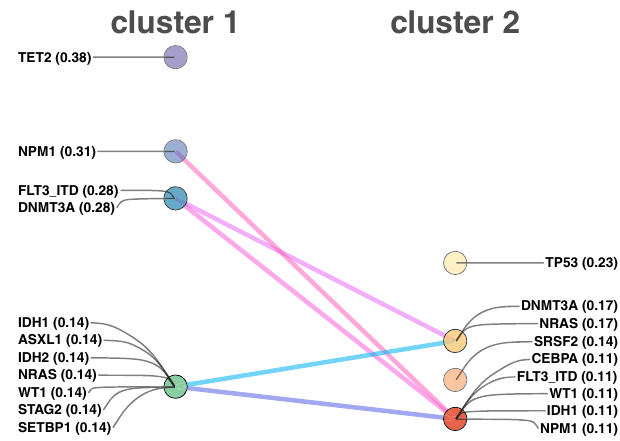
Fig. 6 The frequently mutated genes in the clusters of Beat AML patients. The non-benign mutations with the probability of being damaging is greater than 0.5 were selected to fi nd the intersection of mutated genes. The gene names are shown with the relative frequency of mutated genes in each cluster (e.g., NPM1 — 0.38 indicates 38% of the patients in cluster 1 have this mutation). The lines between mutated genes highlight the rank shift in the two clusters. Source data are provided as a Source Data fi le.